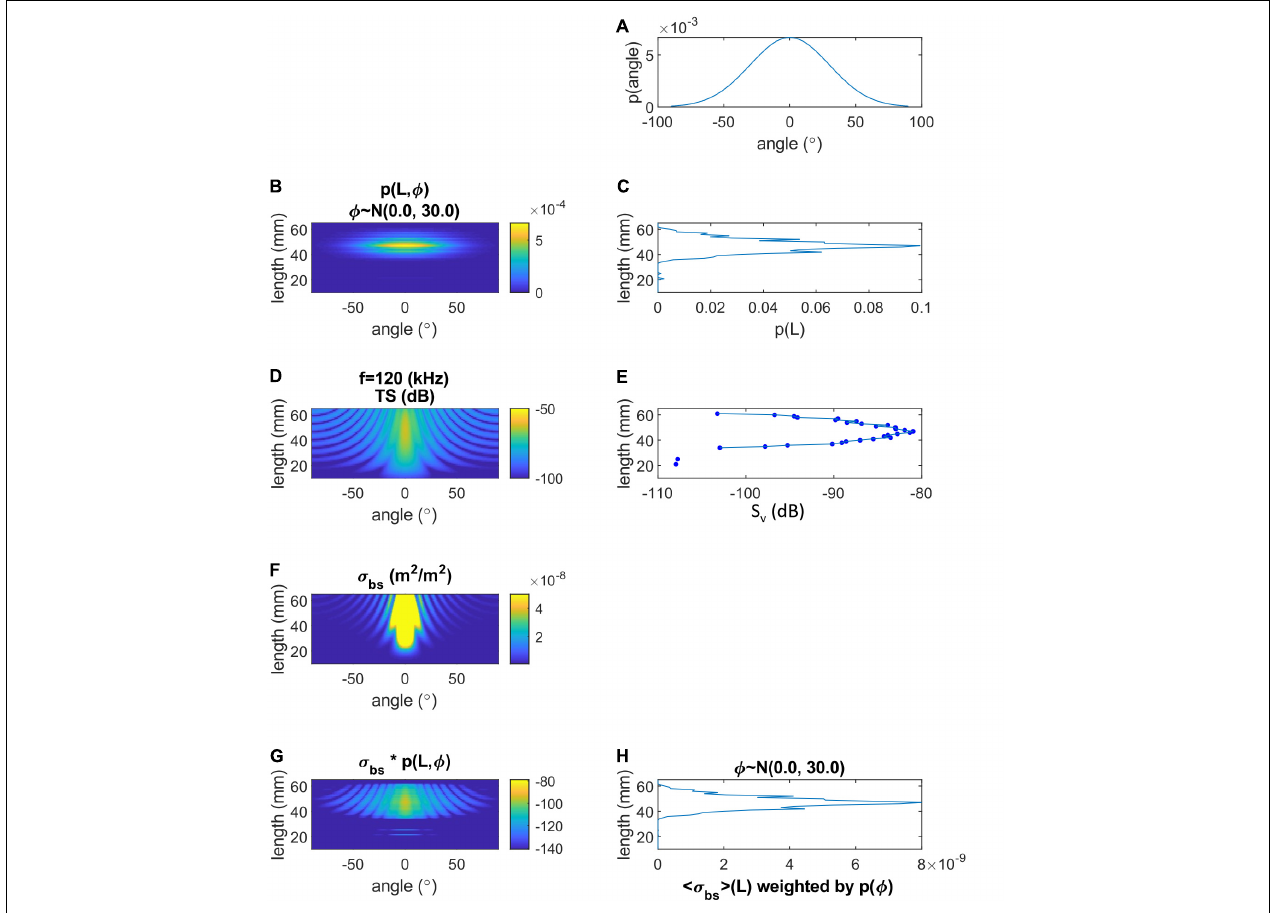
FIGURE 2 | Acoustic target strength (TS; dB) and backscattering cross section ( σ bs ; m 2 ) of krill versus tilt angle ( ϕ ; ◦ ) and length (L; mm), predicted by the DWBA model. (A) Tilt angle distribution, (B) joint distribution of tilt angle and length distribution, (C) length distribution of krill, (D) DWBA-modeled TS by tilt angle and length for 120 kHz, (E) mean S v by length after weighting by angle distribution, (F) σ bs versus angle and length, (G) product of σ bs and p(L, ϕ ) versus angle and length, and (H) σ bs weighted by angle distribution versus